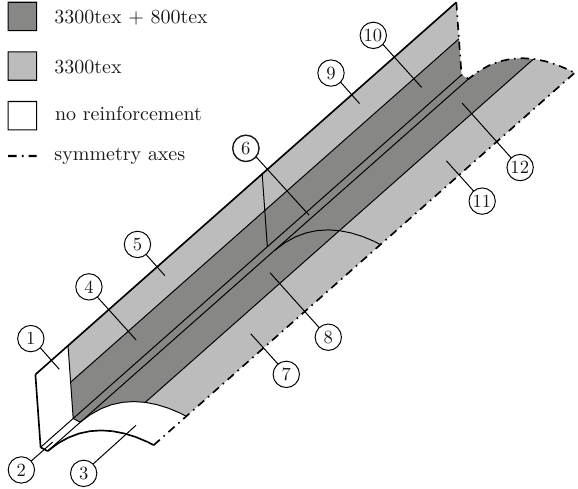
Figure 16. Cross sections of the girder with the corresponding layouts described in Tables 2 and